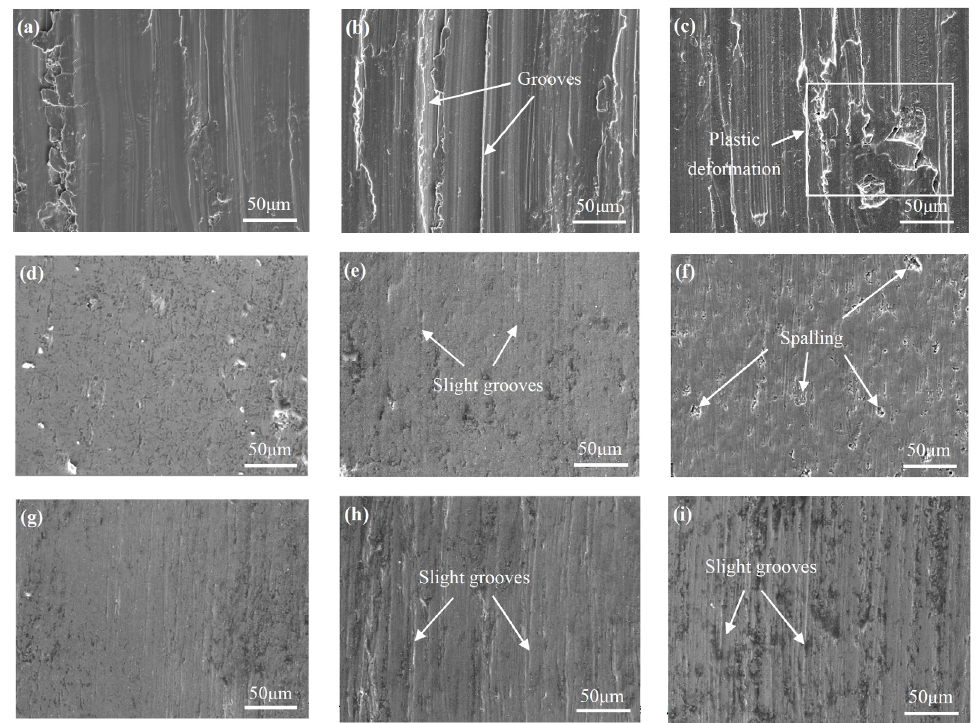
Figure 9. Typical worn surface morphology images of ( a , b and c ) the Ti6Al4V substrate, the coatings ( d – f ) without CeO 2 , and ( g – i ) modified with CeO 2 at ( a , d , g ) 30, ( b , e , h ) 60, and ( c , f , i ) 90 min wear ( d , e and f ) without CeO 2 , and ( g , h and i ) modified with CeO 2 at ( a , d and g ) 30, ( b , e and h ) 60, and ( c , f time, and i ) 90 min wear time, respectively.